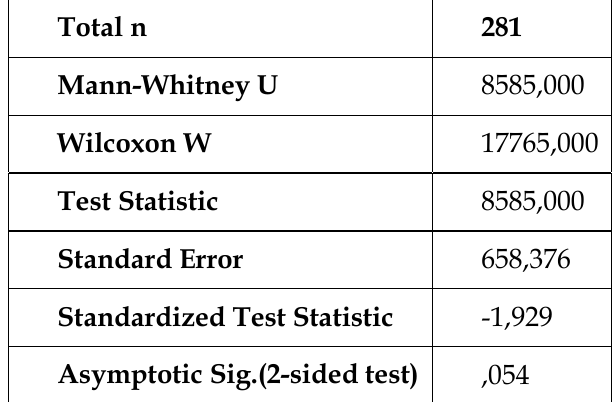
Table 13. Concern about breaching personal privacy and gender. Mann-Whitney U sig.